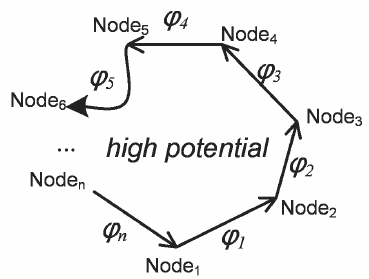
Figure 3. Construct diagram for a potential field of face or surface elements.